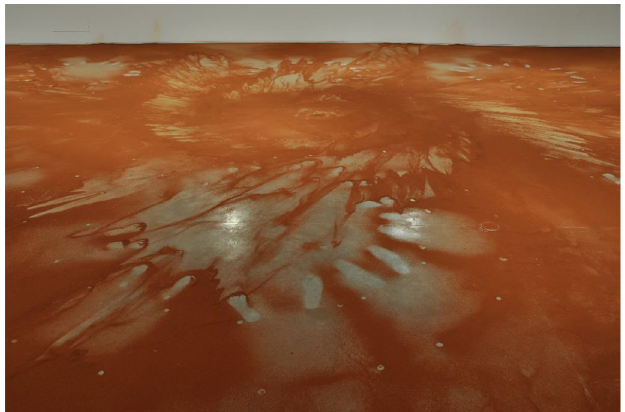
Figure 12. Micha Ullman, Wedding, 2011. Israel museum, Jerusalem, sand throwing installation. Red Sand, about 100 participants, 268 sq. m. Photograph: Avraham Hay.